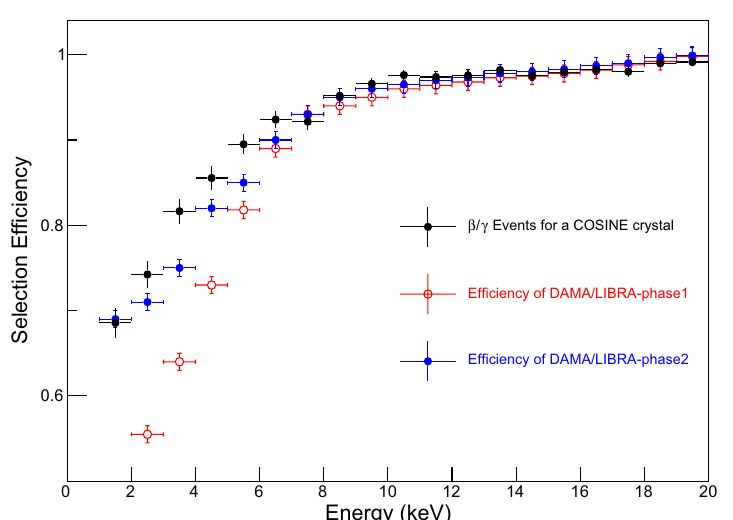
Figure 1. The ES parameter vs energy applied to data from COSINE-100. The DAMA’s ES parameters for the PMT-induced noise rejection as a function of energy are presented for the hit events (left) and three years of COSINE-100 physics data of the single-hit events (right). Solid red lines present selection criteria that provide selection efficiencies similar to the DAMA/LIBRA-phase2.